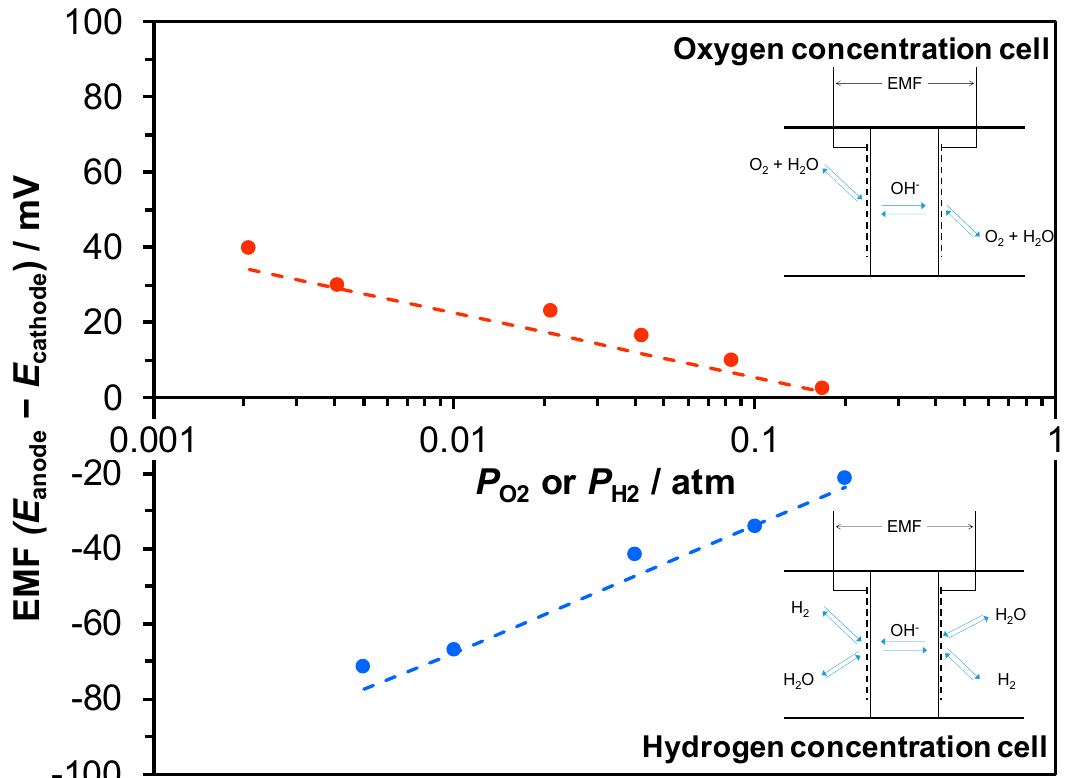
Figure 7. Electromotive forces (EMFs) generated from hydrogen and oxygen concentration cells at 70 °C as a function of P H2 and P O2 , respectively. The dotted lines show the theoretical values for each gas concentration cell.